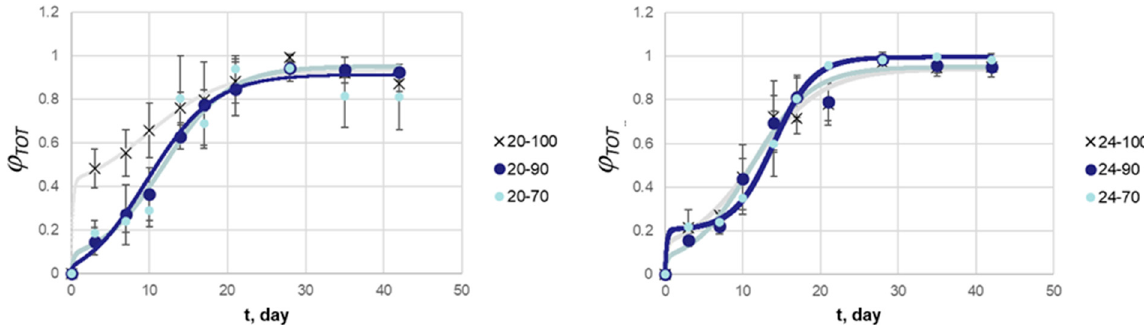
Figure 2. In vitro protein release kinetics from PLGA—based microparticles at 20% ( left ) and 24% ( right ) w/v overall polymer content in the organic phase of the emulsion. Solid lines represent numerical simulations.